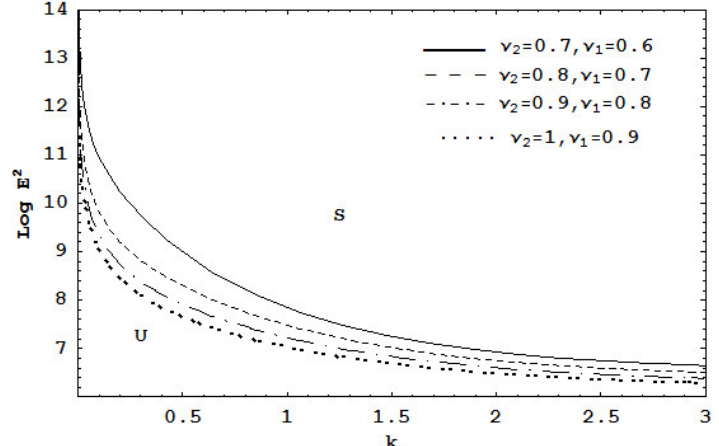
Figure 4. Variation of the electric field intensity log E 2 kinematic viscosities ν 1 , ν 2 .